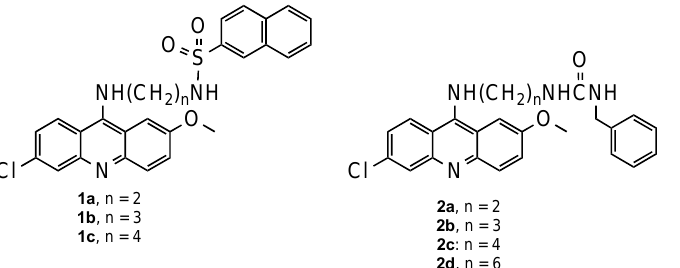
Figure 2. QN derivatives 1 and 2 developed by Chibale and co-workers [12].